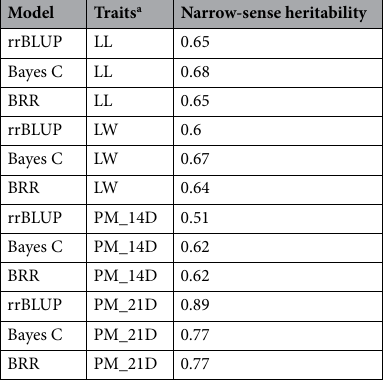
Table 2. Genomic heritability (narrow-sense heritability) of the combined analyzed phenotypic traits of B. napus genotypes for sclerotinia stem rot obtained using all SNPs. a Traits: LL lesion length, LW lesion